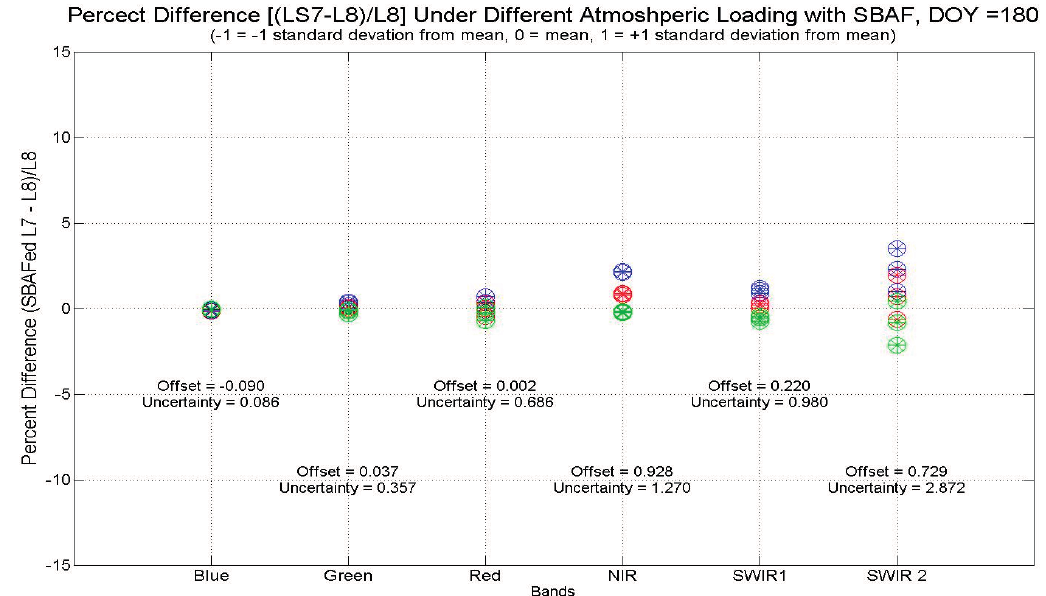
Figure 16. Percent difference between L7 and L8 non-coincident looks—Summer.